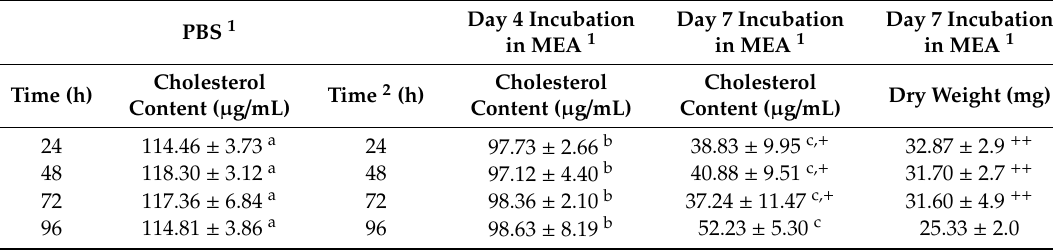
Table 3. Cholesterol content (µg/mL) and dry weight (mg) of M. purpureus CBS 109.07 incubated in phosphate-buffered saline (PBS) and rescued in MEA. All cultures were incubated at 37 °C with 120 µg/mL cholesterol and 0.3% ( w / v ) oxgall bile salts. Resting M. purpureus was washed in PBS + 0.3% oxgall and then transferred to MEA with 0.3% oxgall and 120 µg/mL cholesterol, and sample collected after 4 and 7 days. Data were determined from three independent trials conducted at each time point. Cholesterol content was measured in duplicate via GC-FID. Standard deviation in cholesterol content is absolute error.